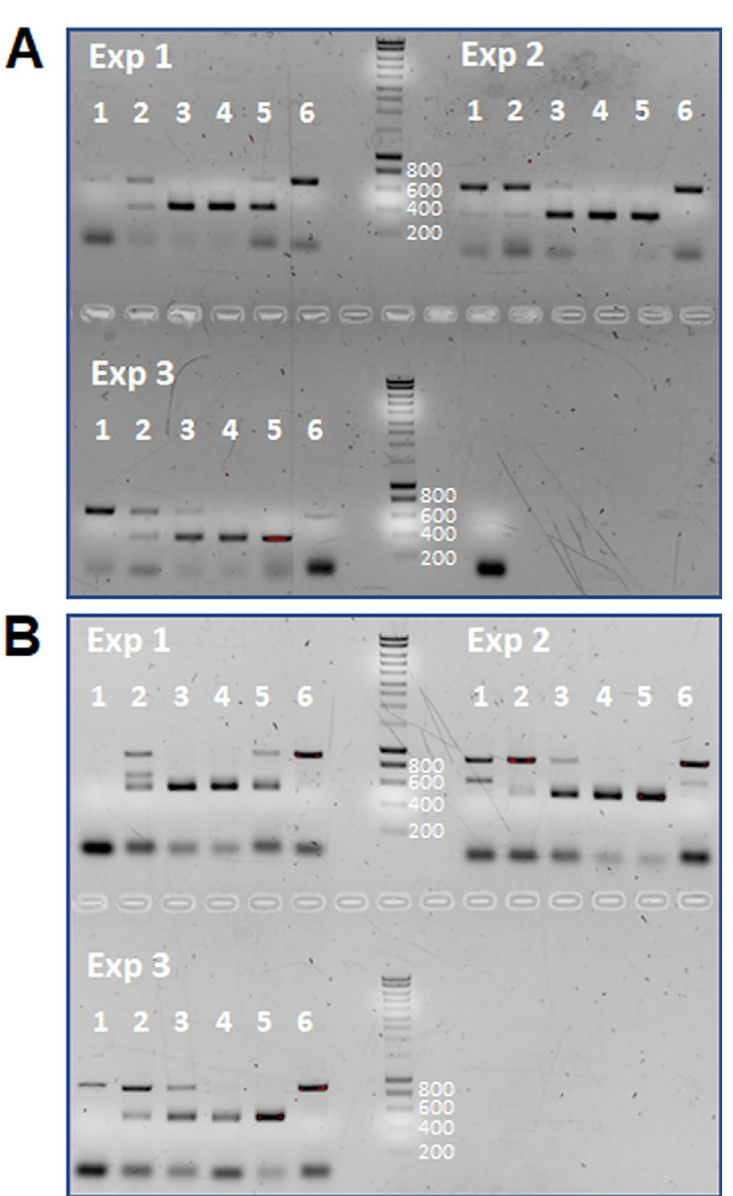
Fig 2. PCR analysis of mixtures of parasite cells and human HepG2 cells. A constant number of 10 6 human HepG2 cells has been mixed with 10 2 (lanes 1), 10 3 (lanes 2), 10 4 (lanes 3), 10 5 (lanes 4), 10 6 (lanes 5) and no (lanes 6) parasite cells prior to DNA extraction and PCR. Analyses in (A) have been performed with primer-set 1 (expected size 374 bp), those in (B) with primer-set 2 (expected size 493 bp). Exp1-3 indicates the results of three independently performed experiments. PCR amplificates have been separated on a 1.5% agarose gel and stained with ethidium bromide. DNA marker sizes (in bp) are indicated to the right of the marker lane.